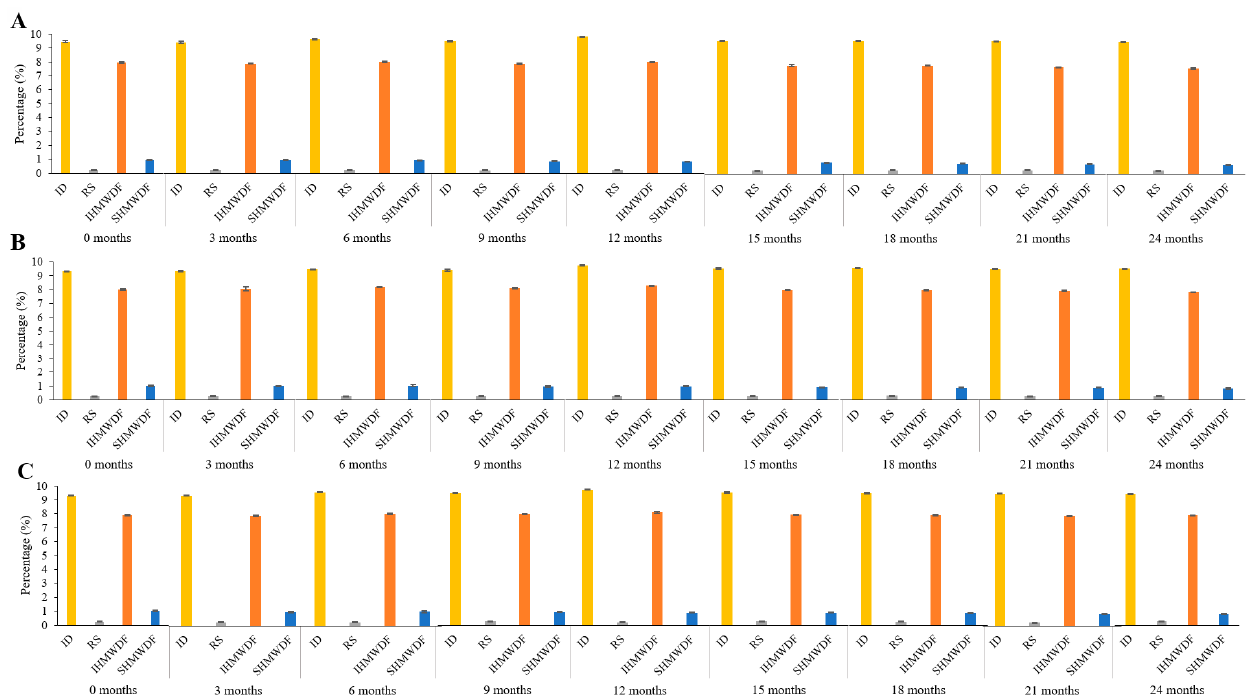
Figure 1. Fiber profile of wheat noodles fortified with isomaltodextrin during different storage period (0, 3, 6, 9, 12, 15, 18, 21, and 24 months) at 25 °C ( A ), 4 °C ( B ), and − 20 °C ( C ). ID, isomaltodextrin; RS, resistant starch; IHMWDF, insoluble high-molecular-weight dietary fiber; SHMWDF, soluble high-molecular-weight dietary fiber.